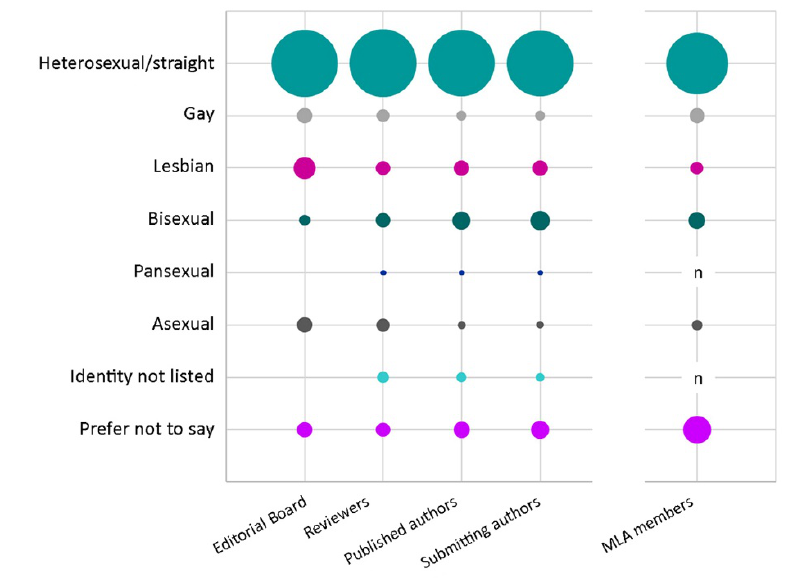
Figure 3 Sexual identity of JMLA editorial board members, reviewers, and published and submitting authors (compared with MLA members